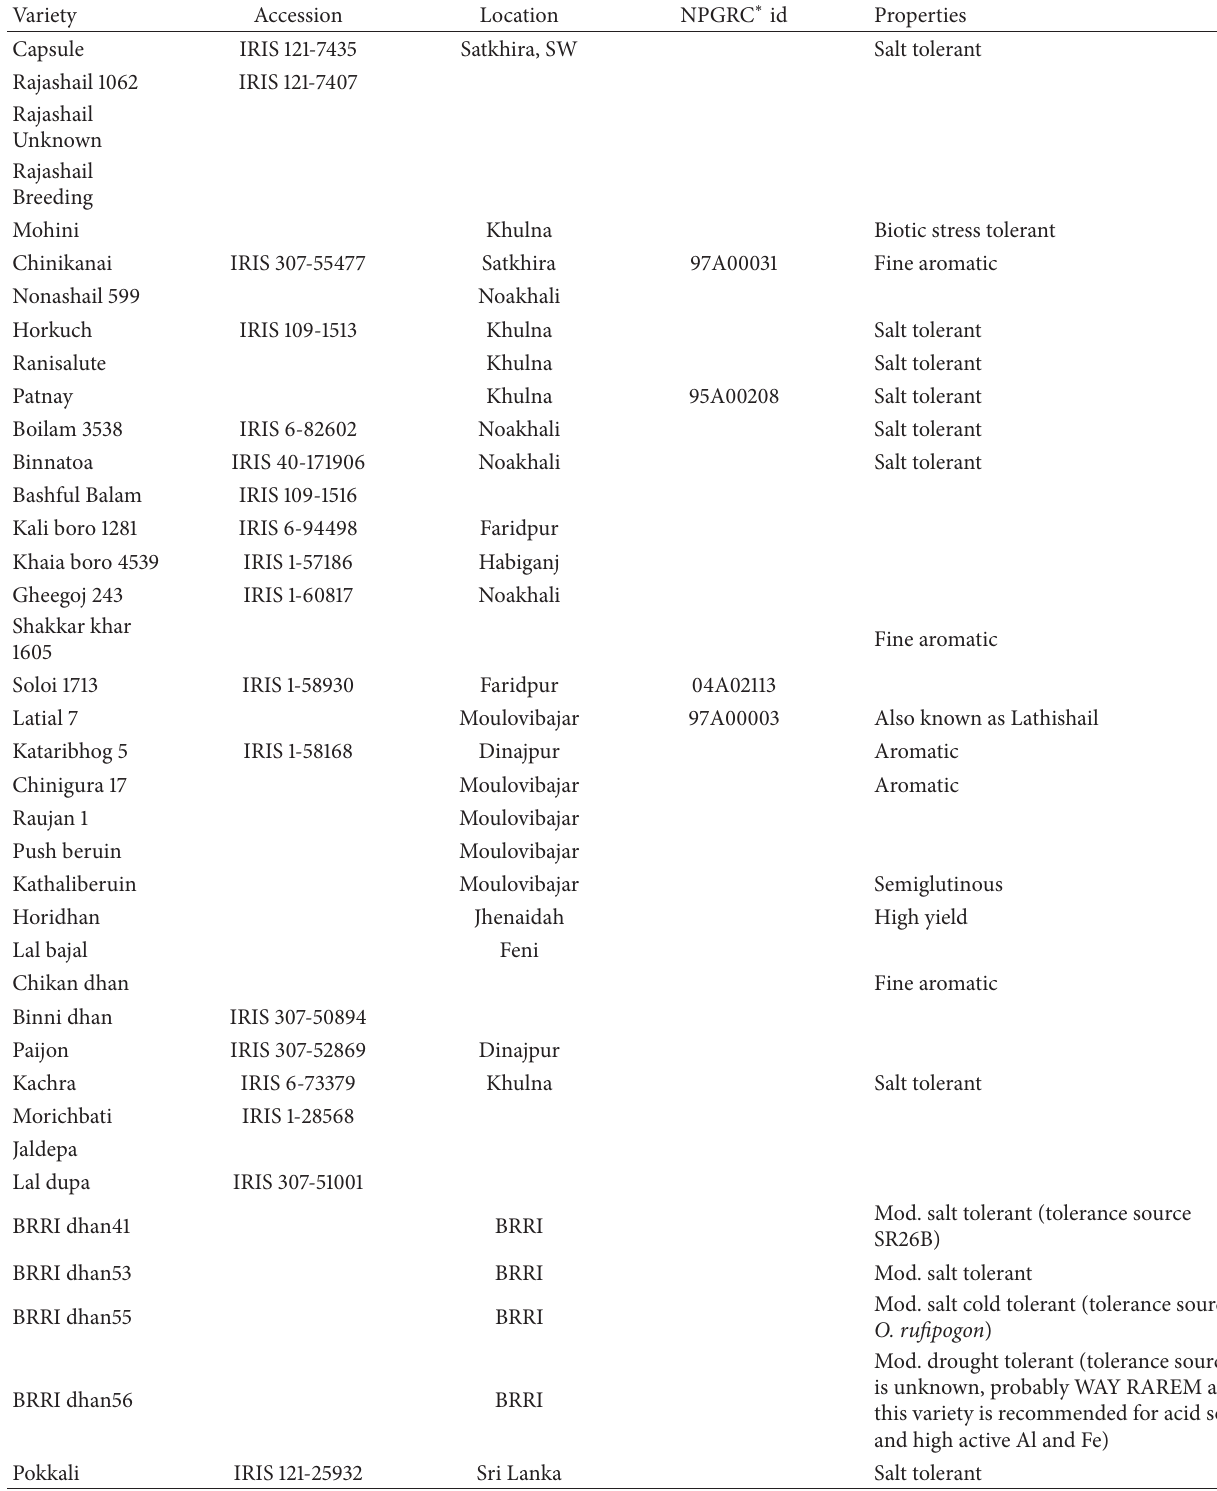
Table 1: List of rice varieties collected from different